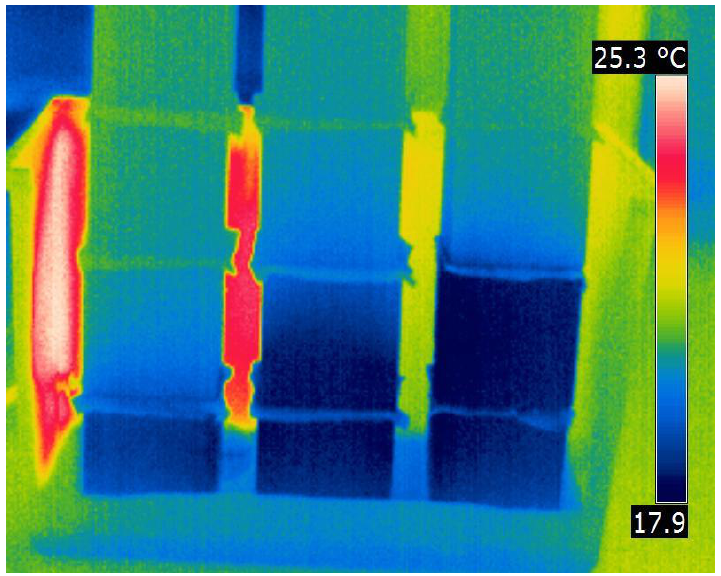
Figure A7. Thermographic report dated November 23, 2018, for Carparo (C.), Lecce stone (L.S.), and Tuff (T.).